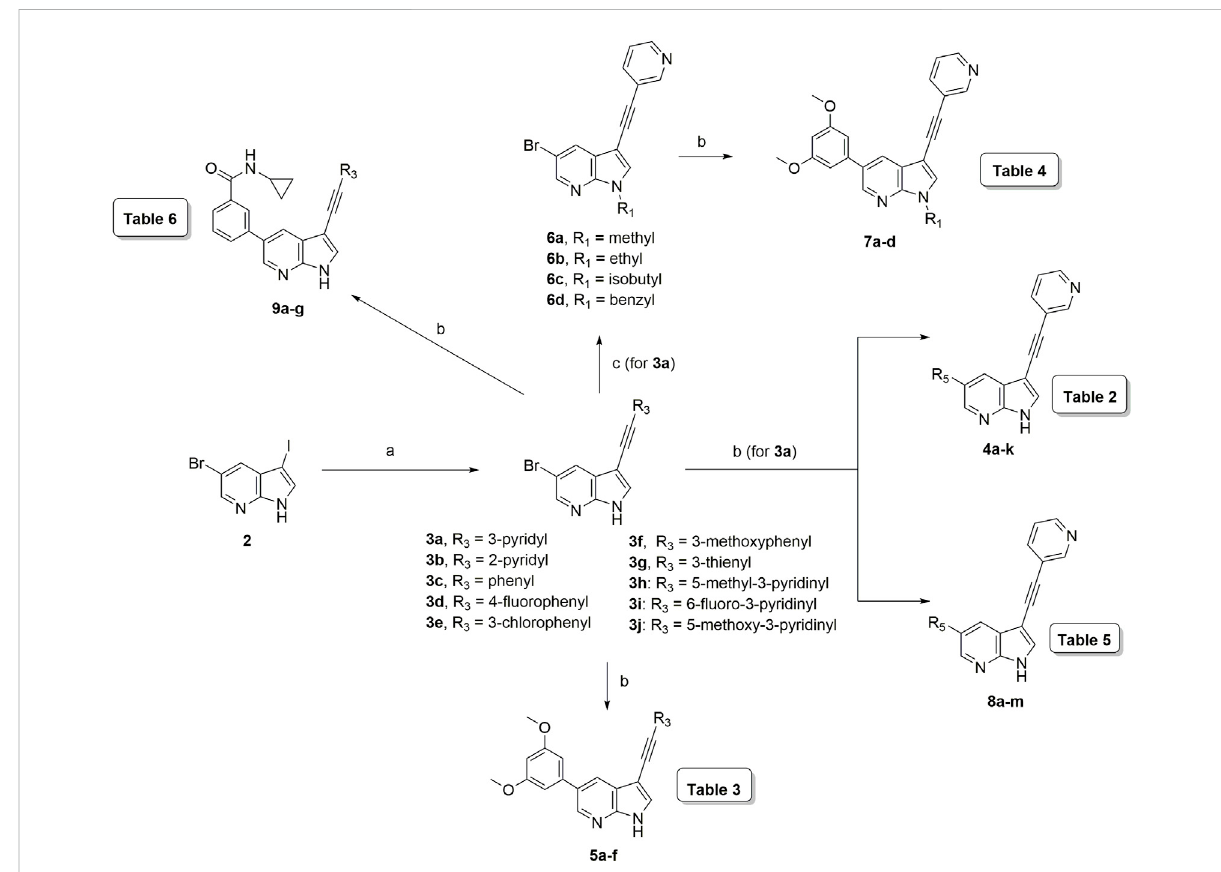
Synthesis scheme of a 3-alkynyl-5-aryl-7-aza-indole library. Reagents and conditions . (A) R 3 CCH, CuI, Pd(PPh 3 ) 2 Cl 2 , Et 3 N, THF, 30 ° C; (B)